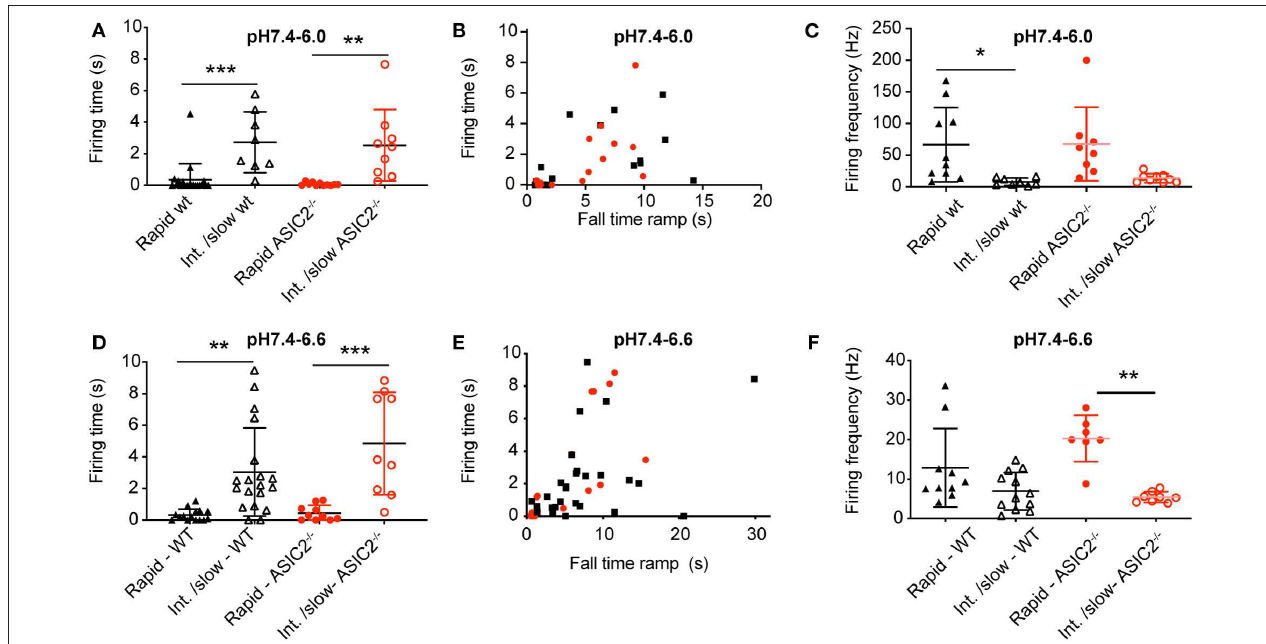
FIGURE 7 | Analysis of acid-induced action potential firing in cultured cortical neurons. The experimental conditions were as described in the legend to Figure 6 . (A,D) Firing time, calculated as the duration between the beginning of the first and the end of the last AP in AP bursts, plotted for pH 7.4–6.0 ramps (A) and